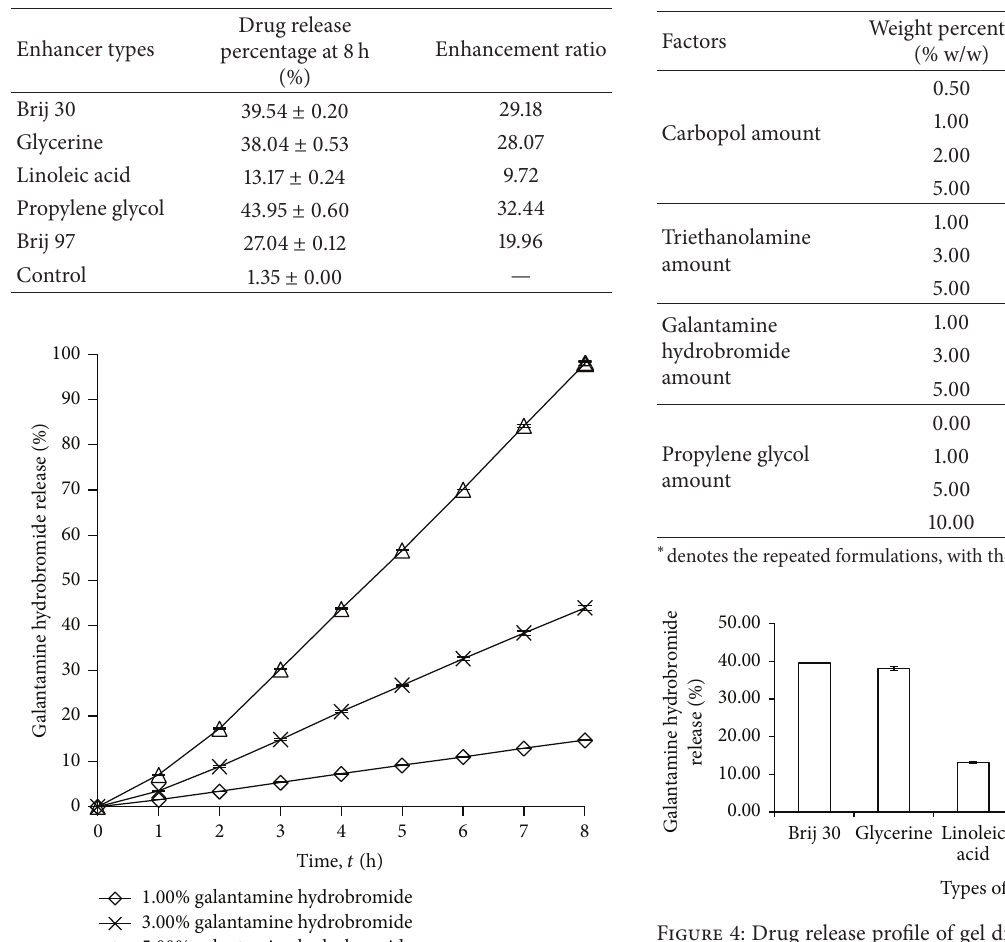
Table 1: Drug release percentage at 8 h and enhancement ratio of each enhancer.